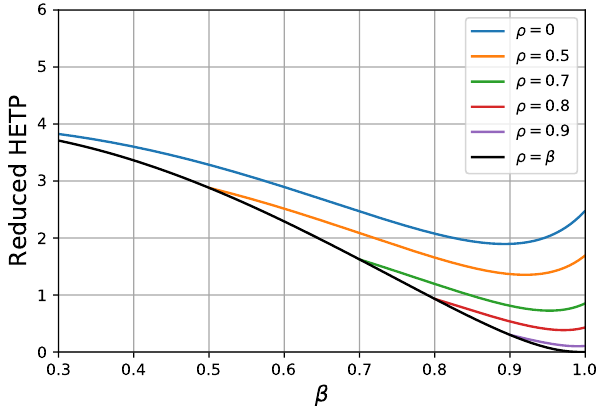
Figure 3. Reduced HETP plotted against the β at different values of ρ .